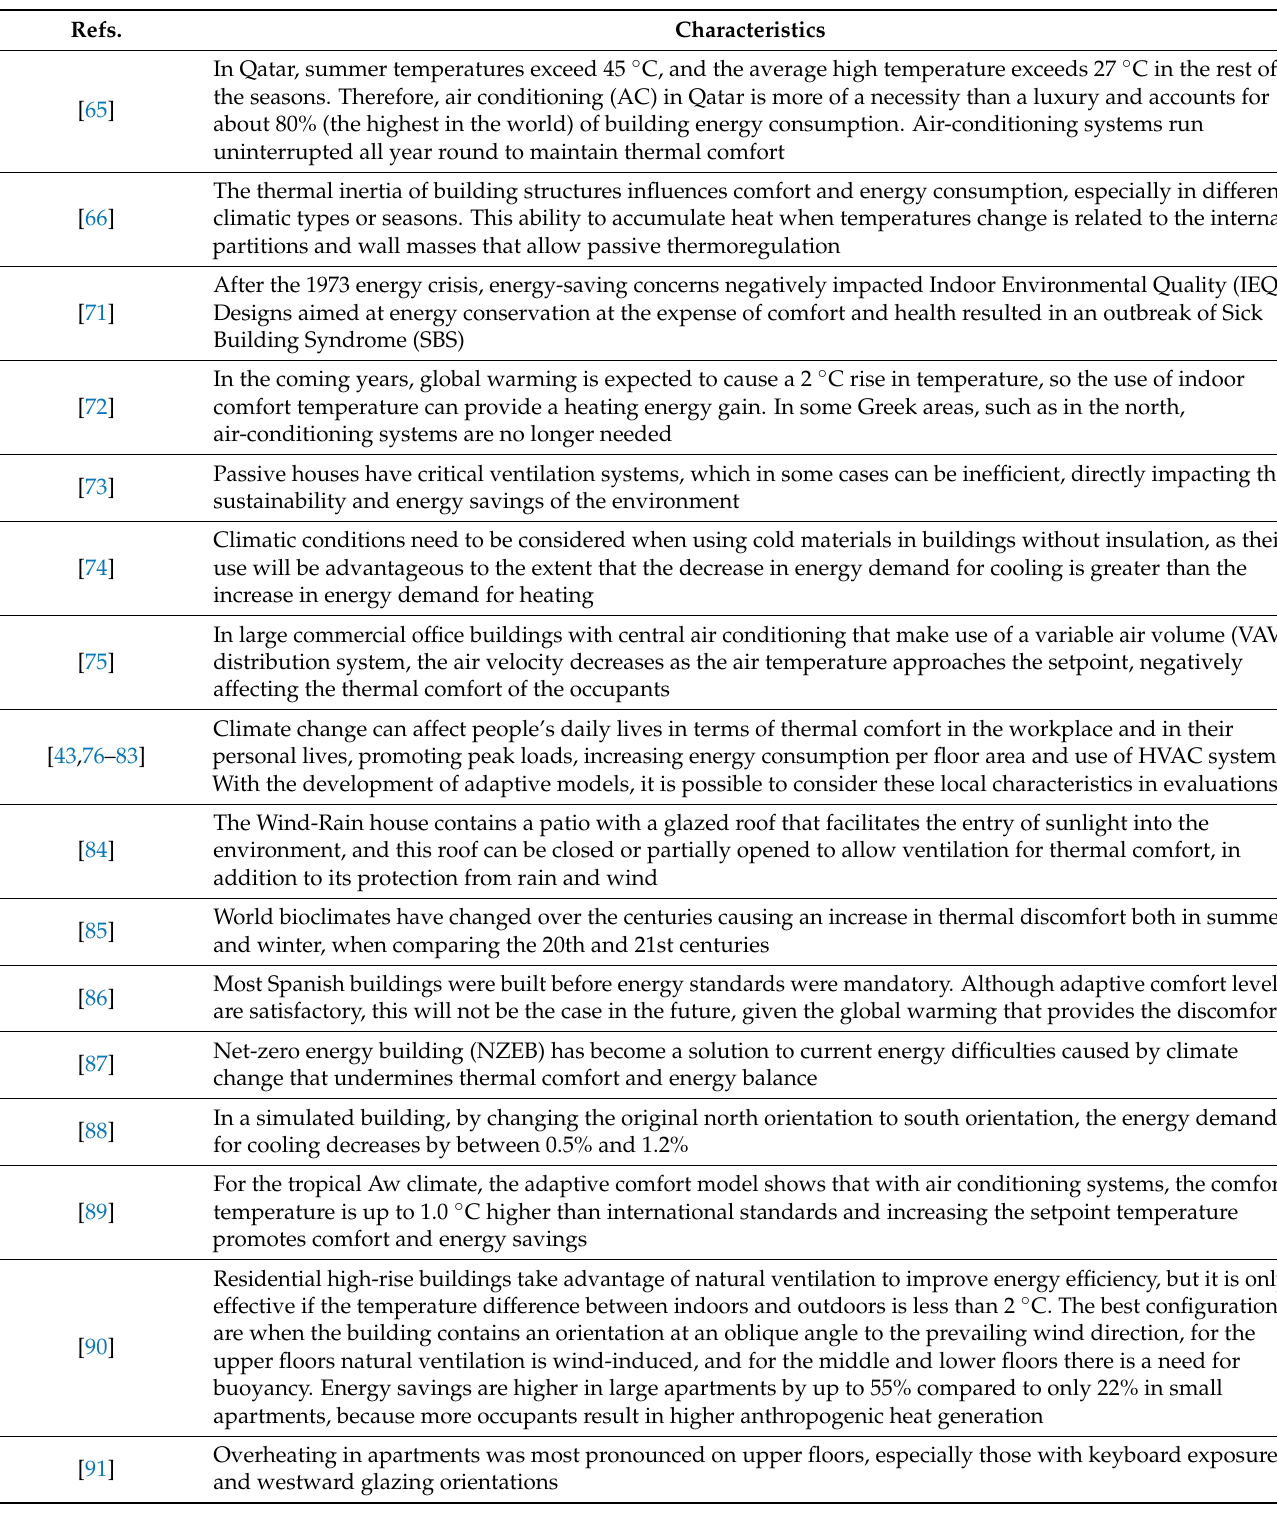
Table 2. Building types, energy levels, and climate